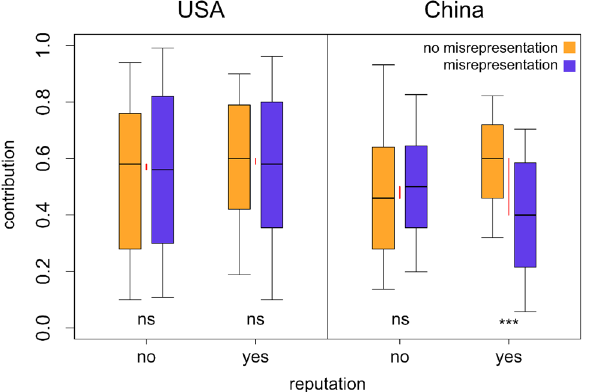
Figure 4. Reputation effects resulted in large contribution differences between the treatments with and without misrepresentation in China, but not in the USA. Boxplots show median, interquartile range (box) and the 10% and 90% quantiles (whiskers). Red lines show the differences in mean contribution rates between the treatments with and without misrepresentation. ‘ns’ (P > 0.05) and ‘***’ (P < 0.001) indicate the significance of Tukey HSD based on a linear mixed model; see “Methods” for